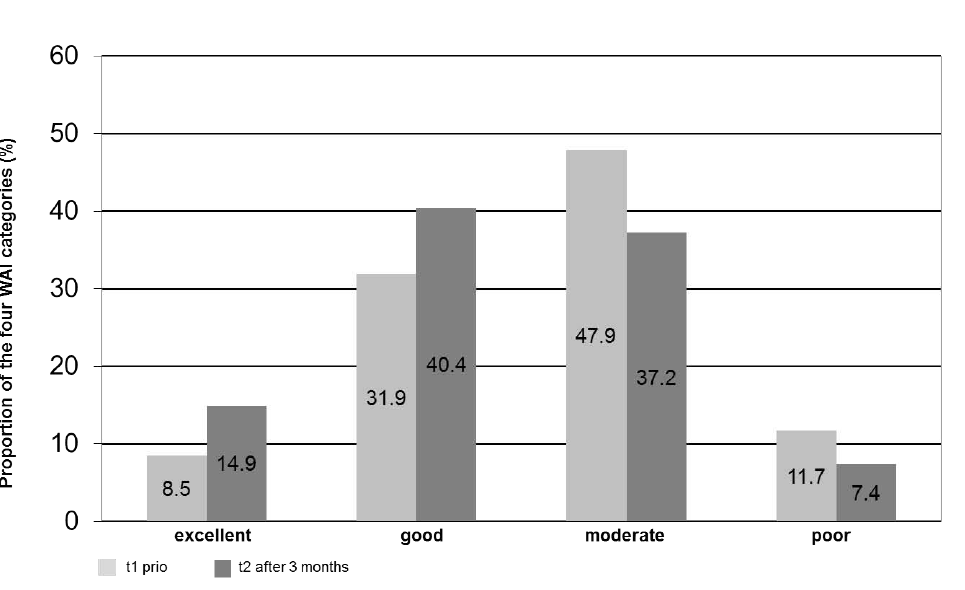
Figure 2. Prevalence of the WAI categories before and after worksite program ( n =